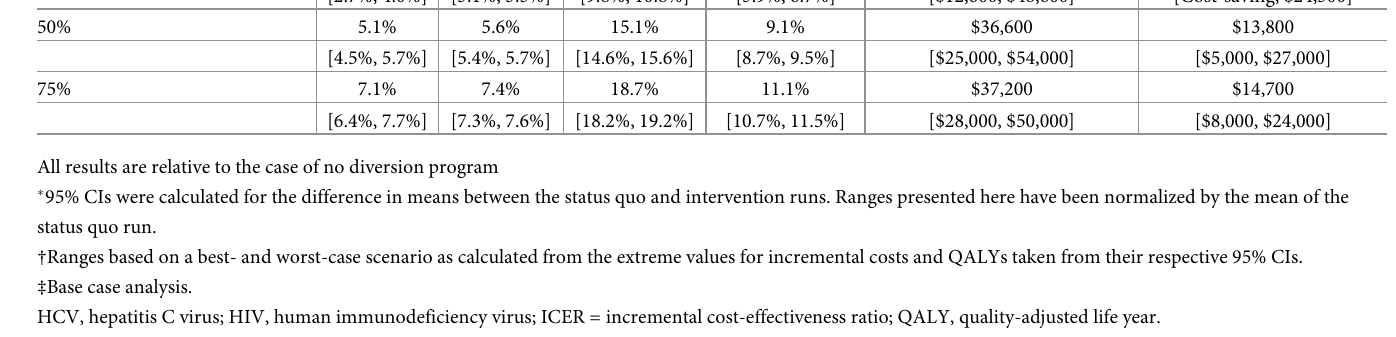
Table 3 assesses sensitivity of results to the fraction of eligible individuals with misde- meanor arrests who enrolled in the diversion program; this reflects both program capacity and participant willingness. We considered values of 10%, 25% (base case value), 50%, and 75%. As the enrollment probability increased, HIV and HCV transmission, fatal overdoses among PWID, and the size of the jailed population uniformly decreased. Despite slight decreases in projected value as enrollment increases, the program was cost-effective at all enrollment levels. This sensitivity analysis suggests that low or moderate enrollment levels can provide high value and that municipalities can continue to gain substantial health benefits and criminal jus- tice system savings by expanding such a program to maximal enrollment. Table 5 varies assumptions surrounding the indirectly modeled health benefits of the diver- sion program—namely, benefits that accrue from enrollment in community programs (NSP, SUDT, and HIV and HCV treatment). The base case assumed that an individual in the diver- sion program was, on average, twice as likely to attempt to enroll in community programs and